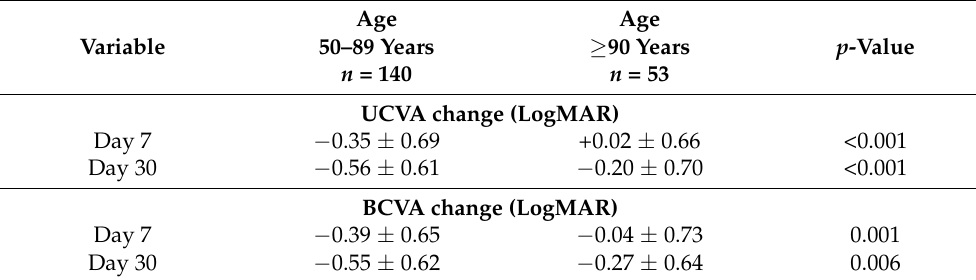
Table 3. UCVA and BCVA change at seven and 30 days after cataract surgery.